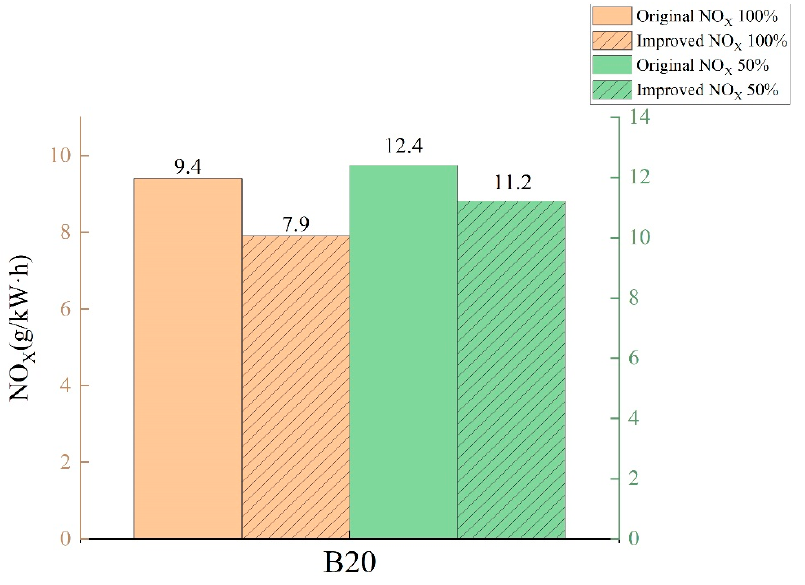
Figure 20. Comparison of improved NO X emissions with original values at 100% and 50%